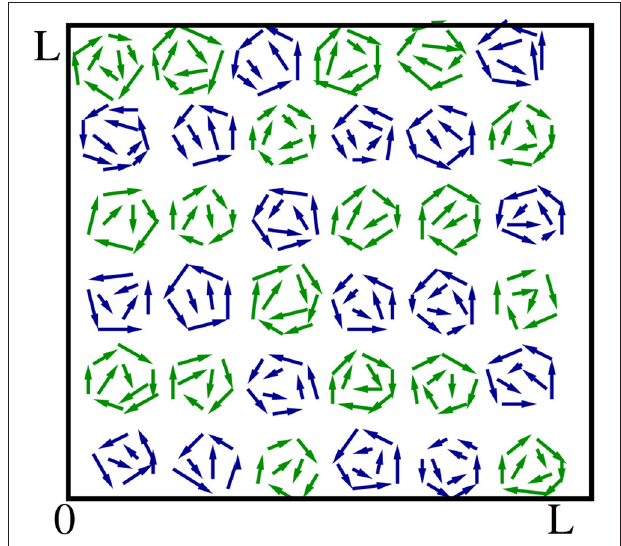
FIGURE 7 | A non-conservative periodic force field for which the Sutherland-Einstein relation gets modified.